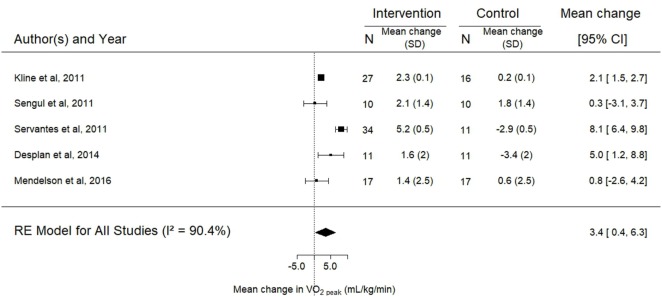
Forest plot for the mean change in peak oxygen consumption (VO2peak) following exercise training. The diamond reflects the 95% confidence interval of the pooled estimate of mean difference. VO2peak measured in milliliter per kilogram per minute. Ref (16, 22, 30, 31, 33).